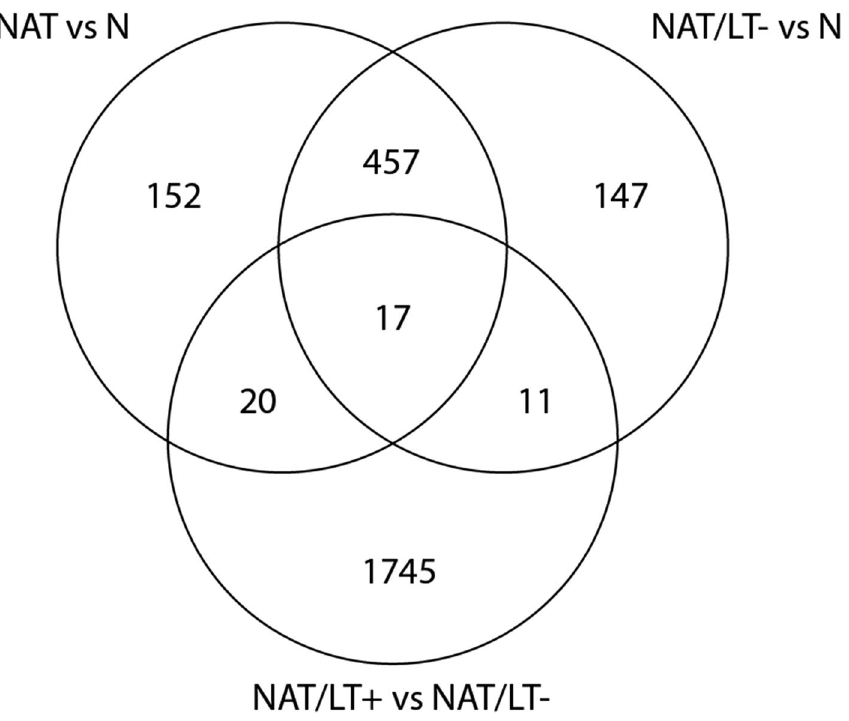
Figure 2. Venn diagram of differentially expressed genes (DEGs) among samples. Venn diagram to illustrate the overlapped DEGs between NAT vs N, NAT/LT− vs N, and NAT/LT+ vs NAT/LT−.